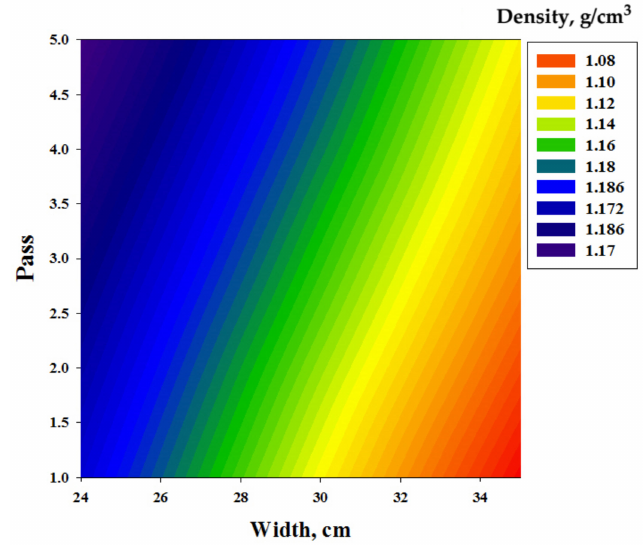
Figure 12. Tire type and traffic effect on the soil bulk density.